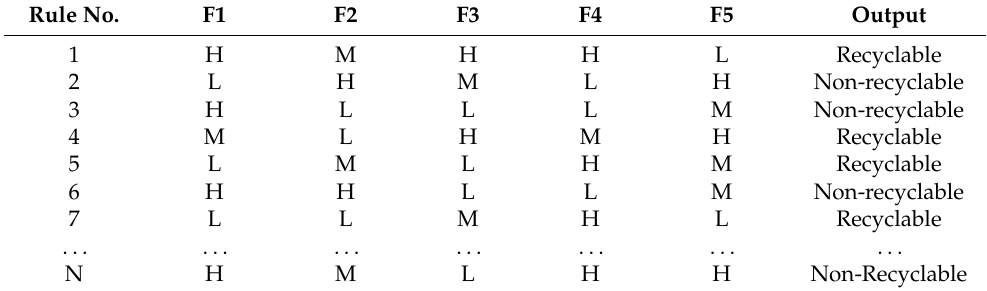
Table 4. Fuzzy rule